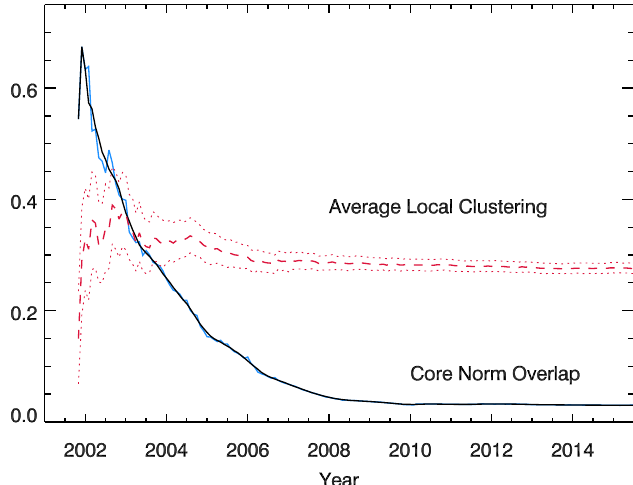
Figure E.1. The average local clustering coefficient, as a function of time. Despite large-scale changes in overall network properties, this local property remains remarkably